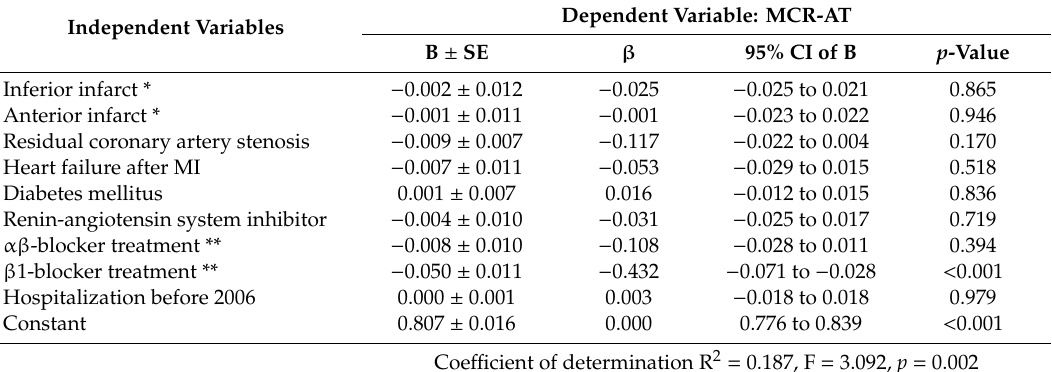
Table 3. Results of multiple regression analysis for the prediction of MCR-AT.